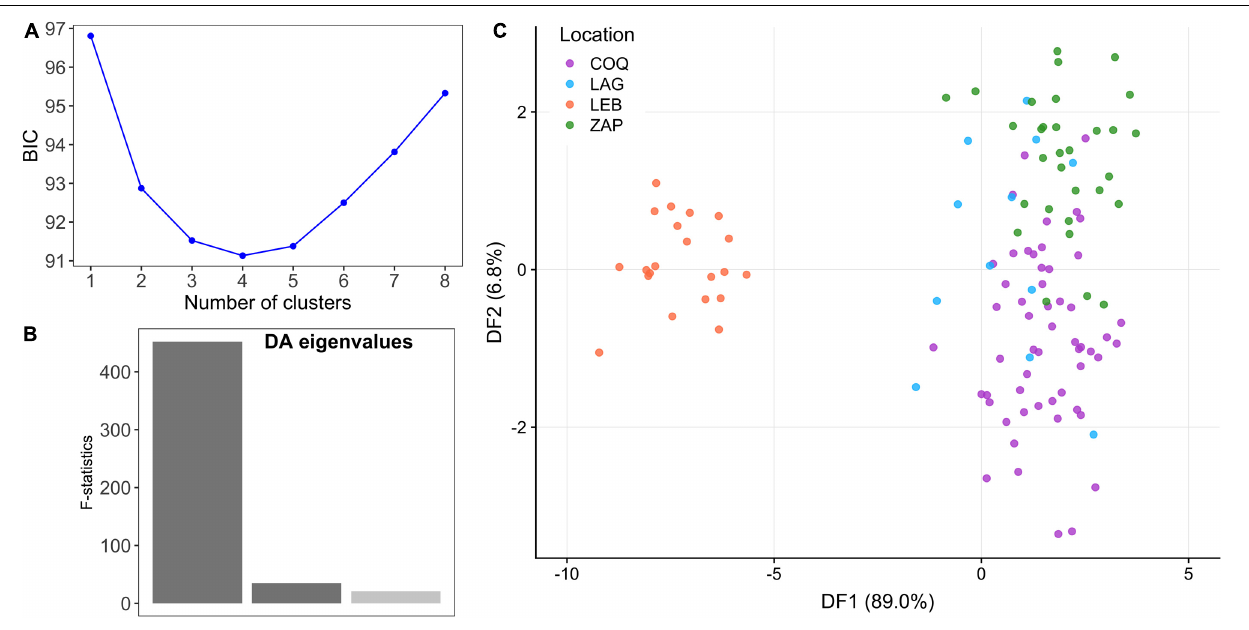
as previously demonstrated by Canales-Aguirre et al.